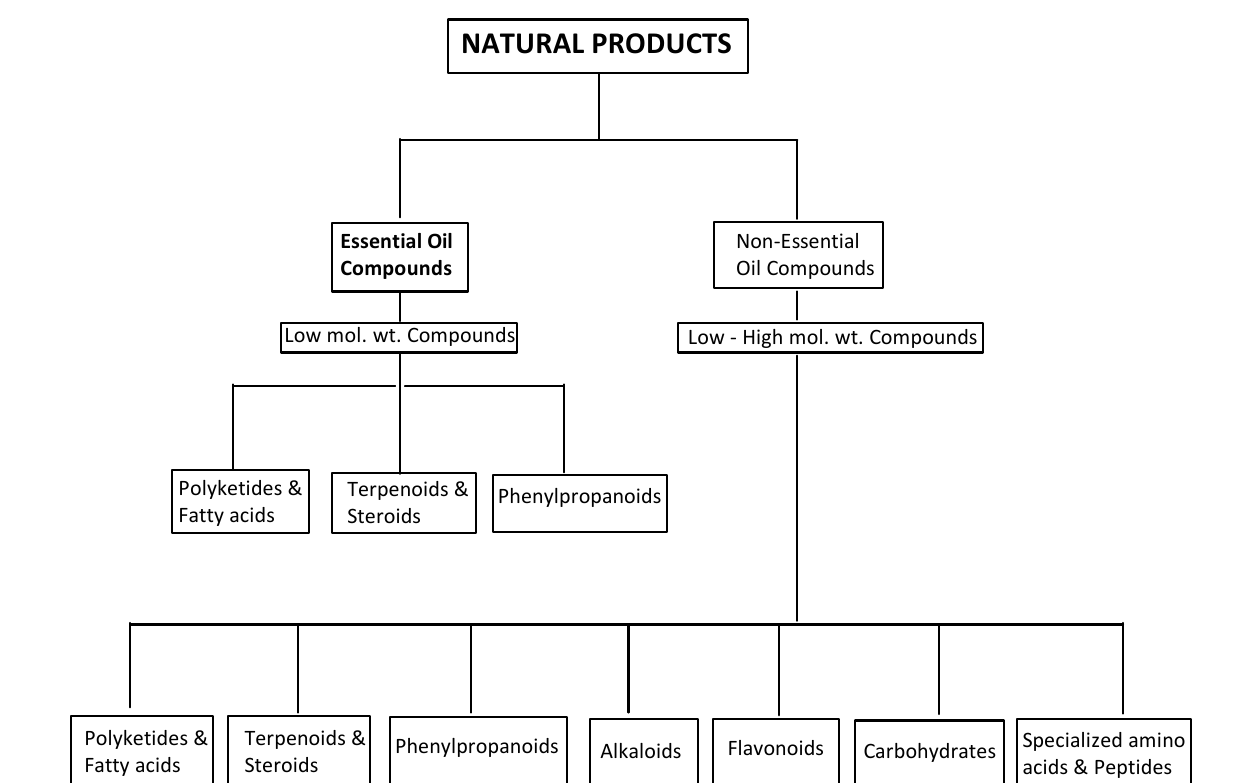
Figure 1. An overview of natural products, showing the essential oil compounds.